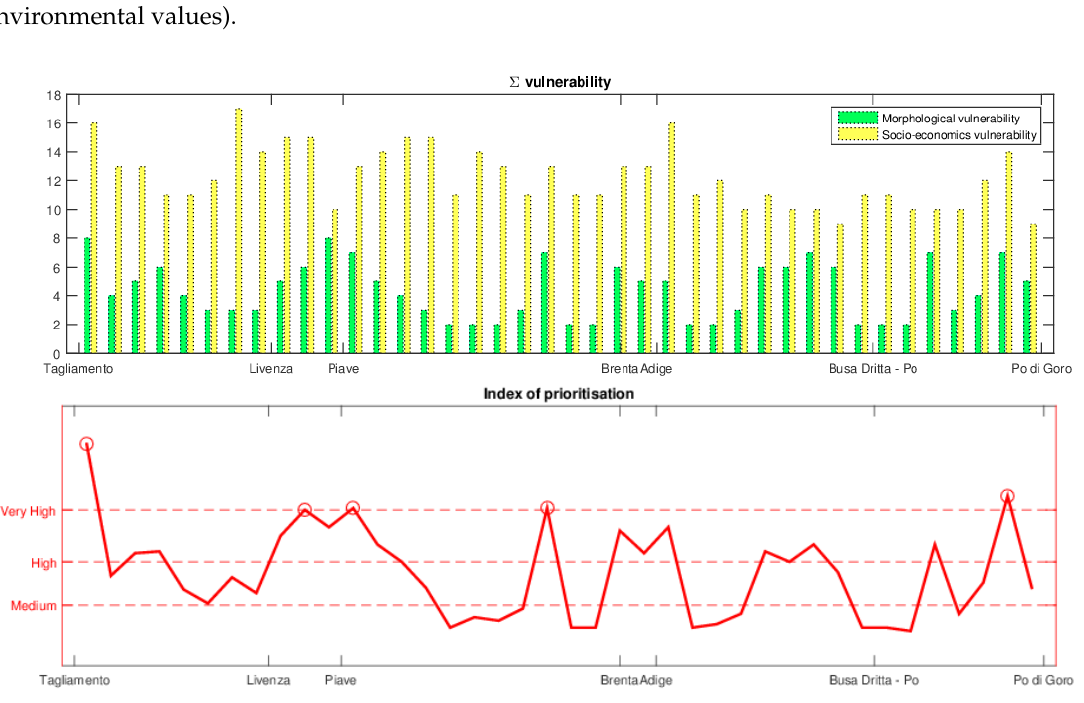
Figure 10. Vulnerability and index of priority.